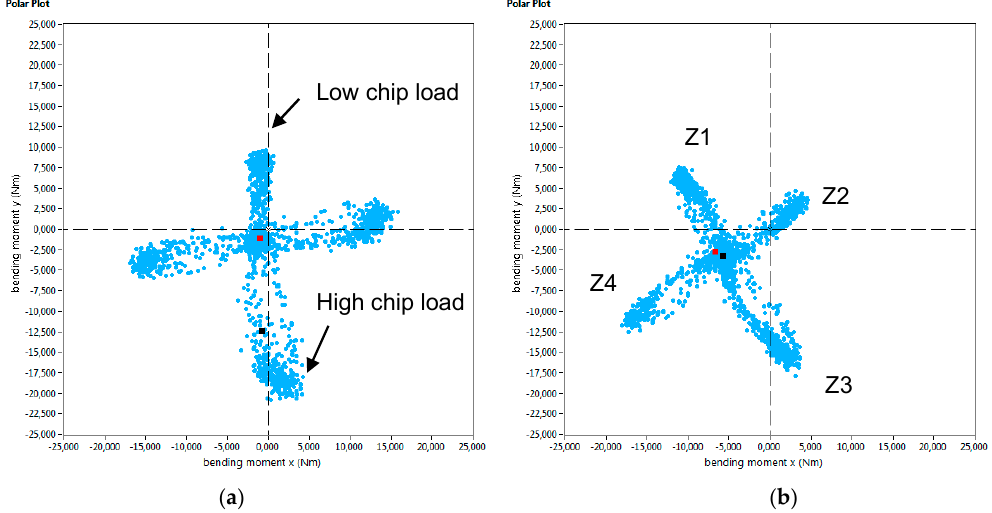
Figure 17. Polar plot of the average bending moment in the second set of experiments.